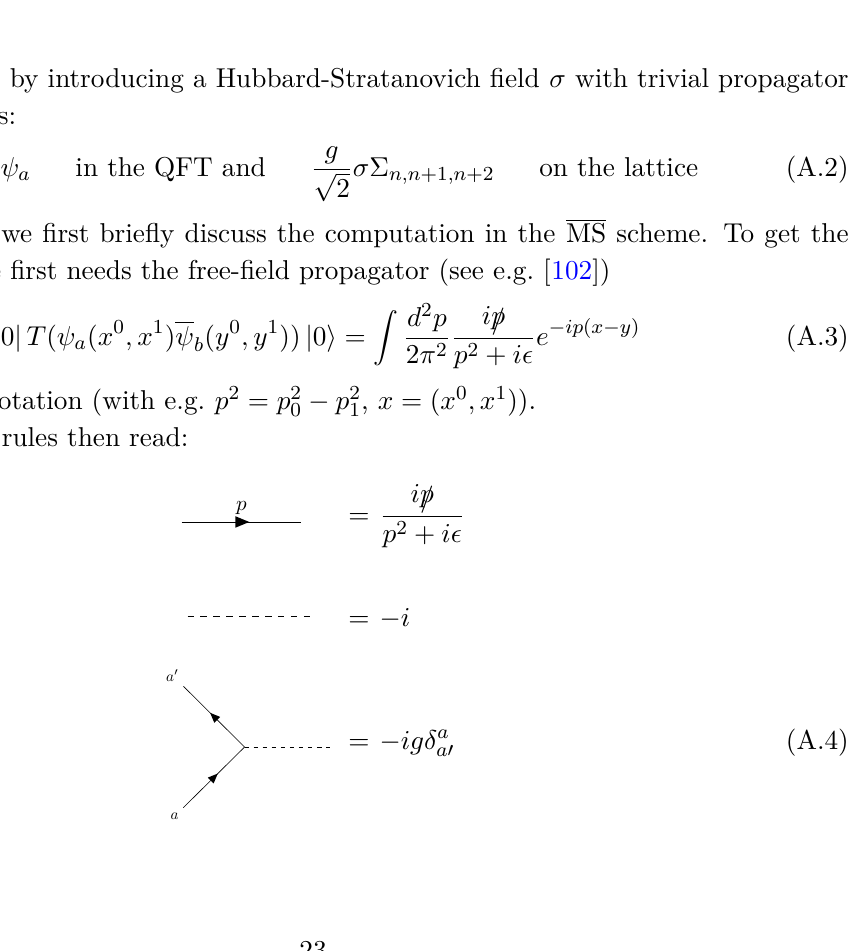
Figure 9 . The Feynman diagrams contributing to the two fermion scattering S -matrix up to second